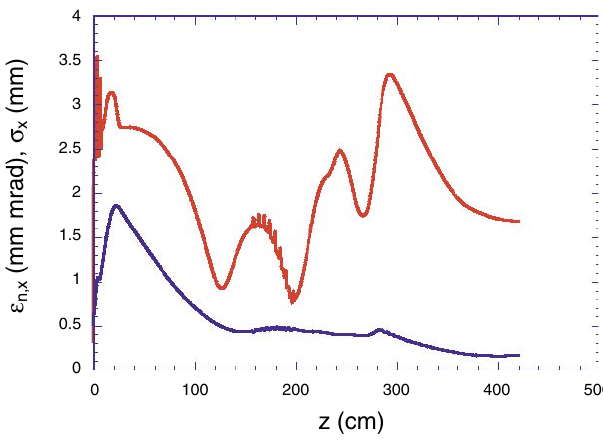
FIG. 5. (Color) Evolution of the rms transverse beam size and emittance for 1 nC beam in the ORION photoinjector, velocity- bunching case, from PARMELA simulation.